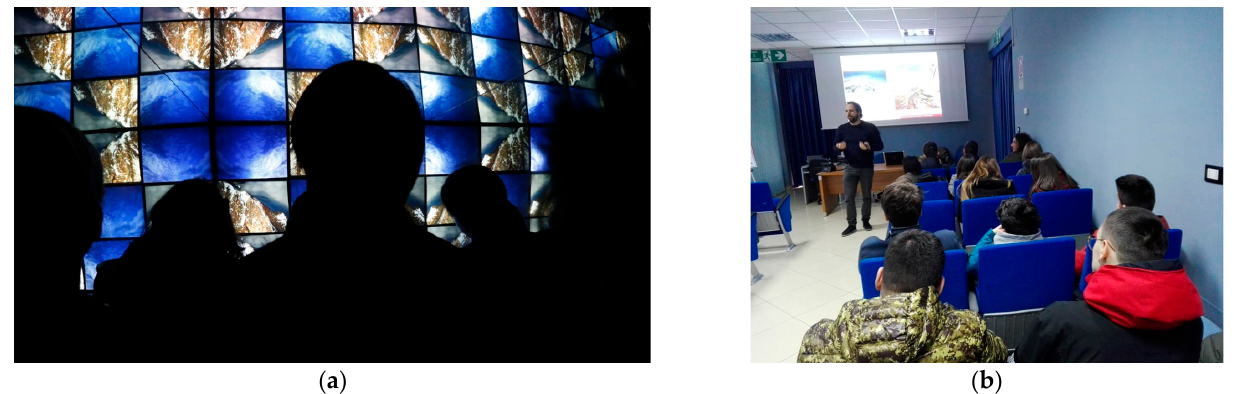
Figure 9. Two moments of IS Ae students’ visits to scientific research institutes: ( a ) the fascinating tale of the birth of the Earth and the appearance of life proposed in a multimedia way by a BioGeo Museum researcher (year 2019); ( b ) a researcher illustrates the research conducted by the INGV during the visit to the research center in Grottaminarda (AV) (year 2018).